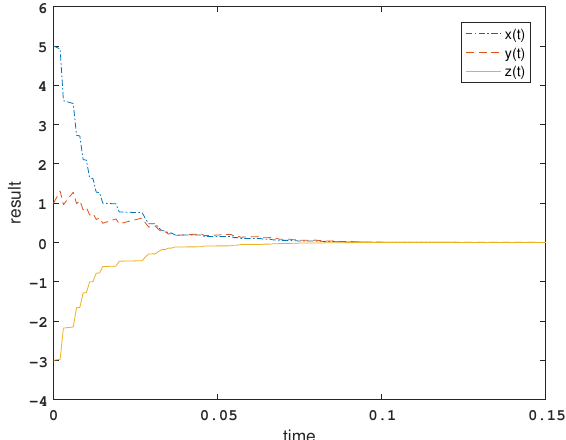
) ∗ diag ( − 0.2, − 0.2, − 0.2 ) , in which case λ t